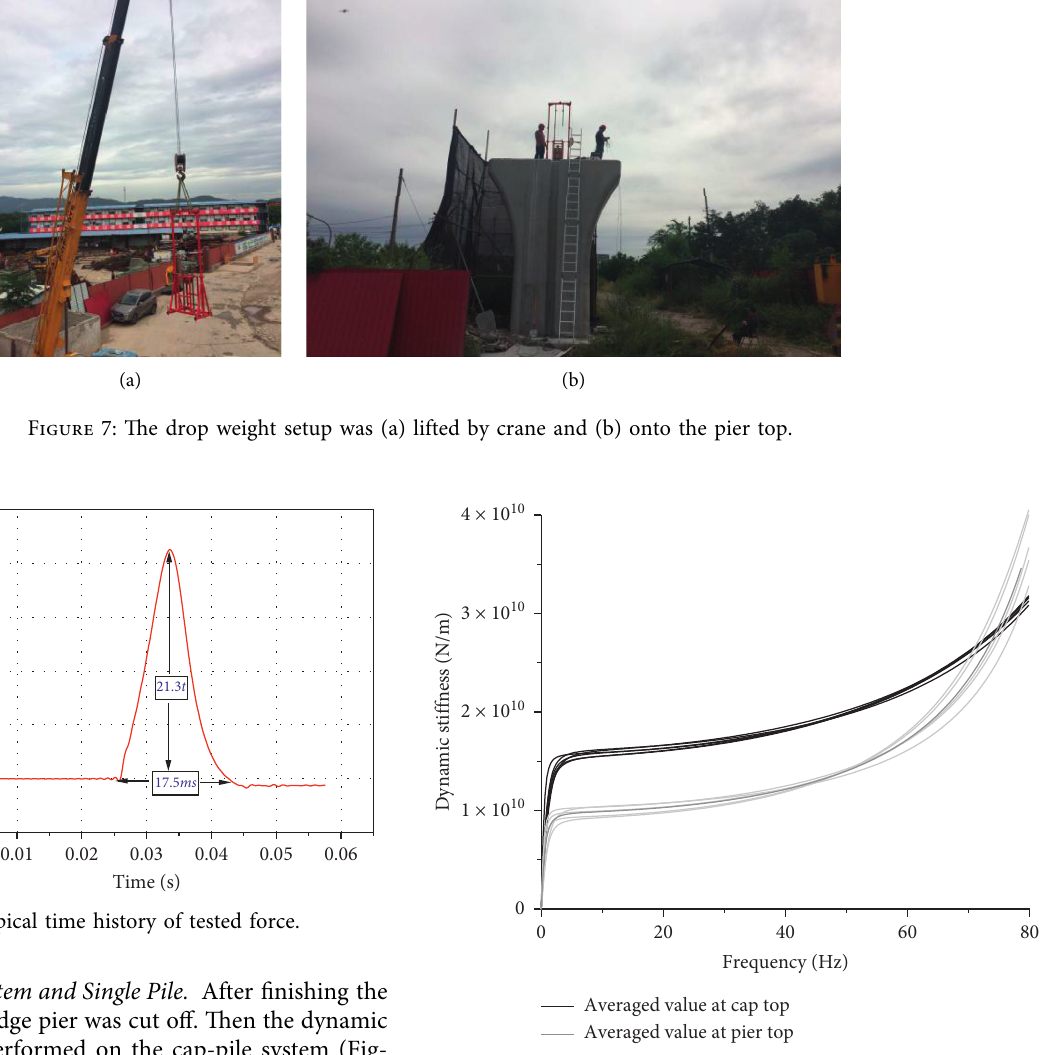
Figure 9: Dynamic stiffness on the pier top and the cap